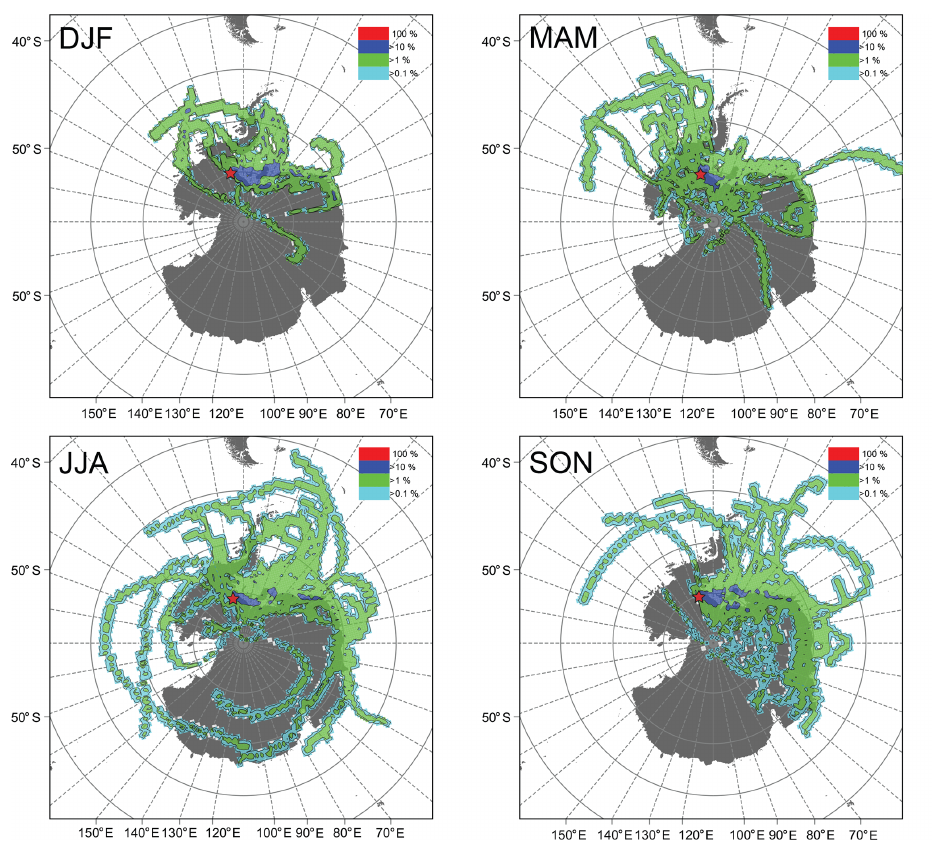
Figure 11. Seasonal frequency distribution of single 5d backward trajectories during precipitation events extracted from ERA-Interim time series of daily precipitation for the UG region (red star) for the period 2010–2015. In total 121 precipitation events with ≥ 1% of the mean annual snow accumulation ( ∼ 2 . 5mmd − 1 ) were considered for this analysis performed with the HYSPLIT